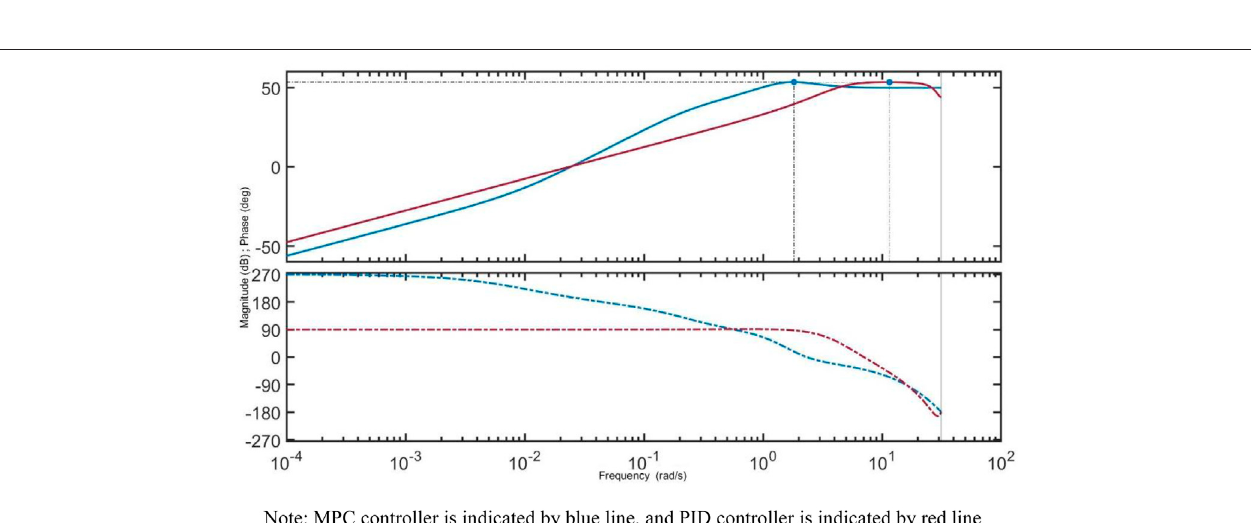
FIGURE 8 | Bode diagram of a core power control system with MPC and PID